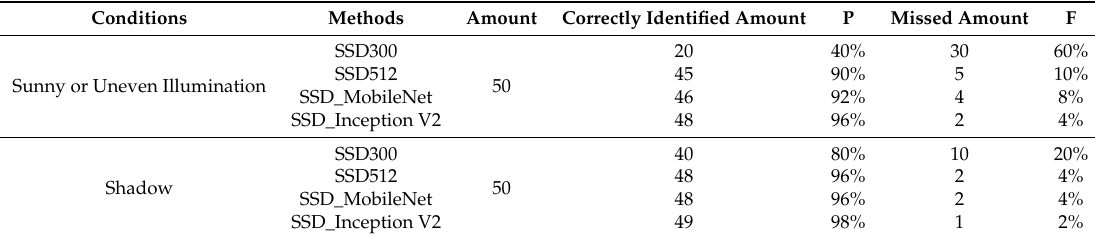
Table 4. The detection results of different methods under different lighting